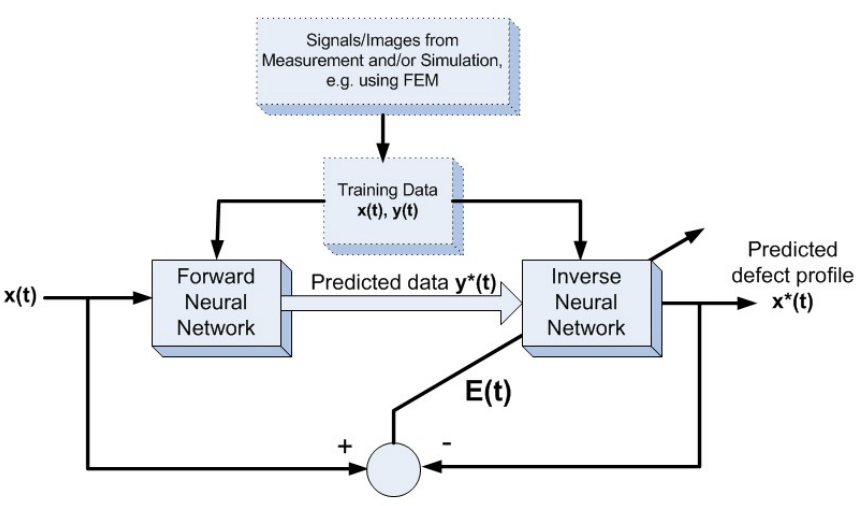
Figure 4. Feedback neural network configuration.